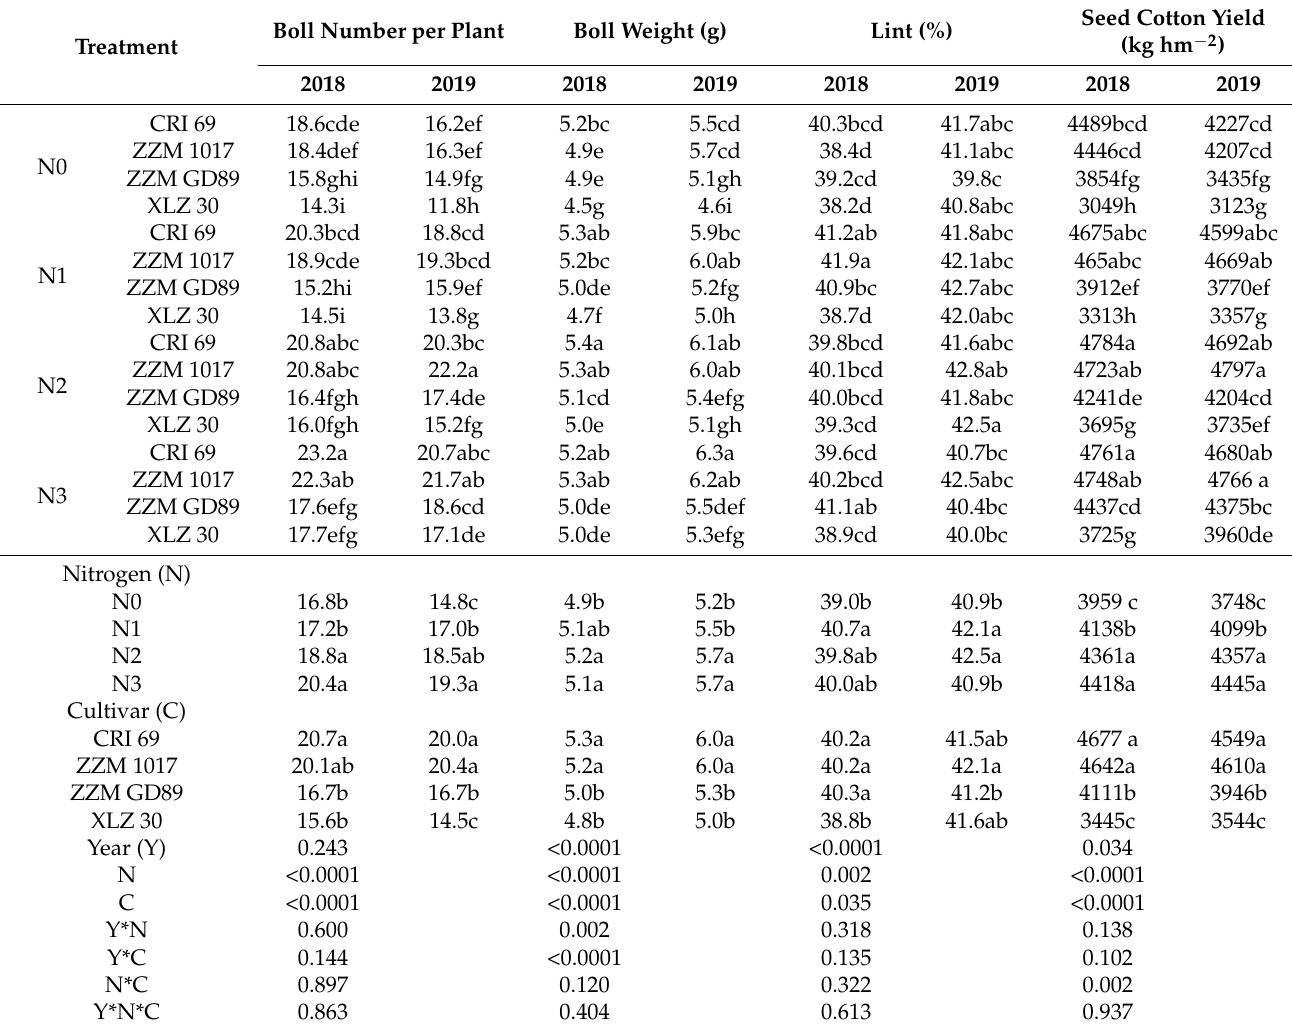
Table 3. Yield and yield components of cotton cultivars under different N-supply conditions in 2018 and 2019